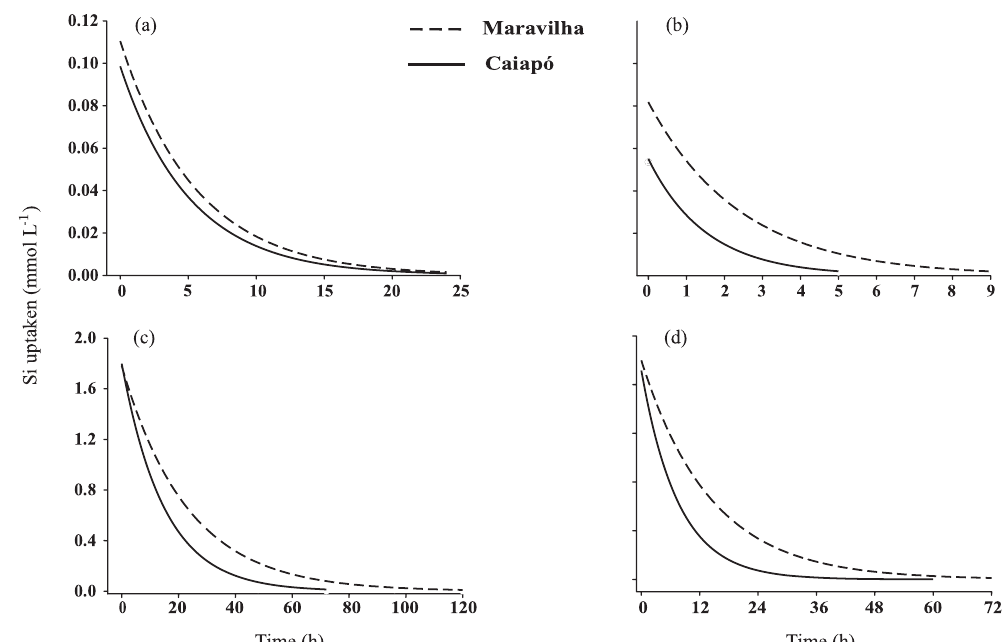
figure 1. Depletion curve of si contained in the growth solution with 0.1 mmol l -1 (a) and (b) and 1.7 mmol l -1 (c) and (d) si applied 25 days (a) and (c) and 40 days (b) and (d) after transplanting rice